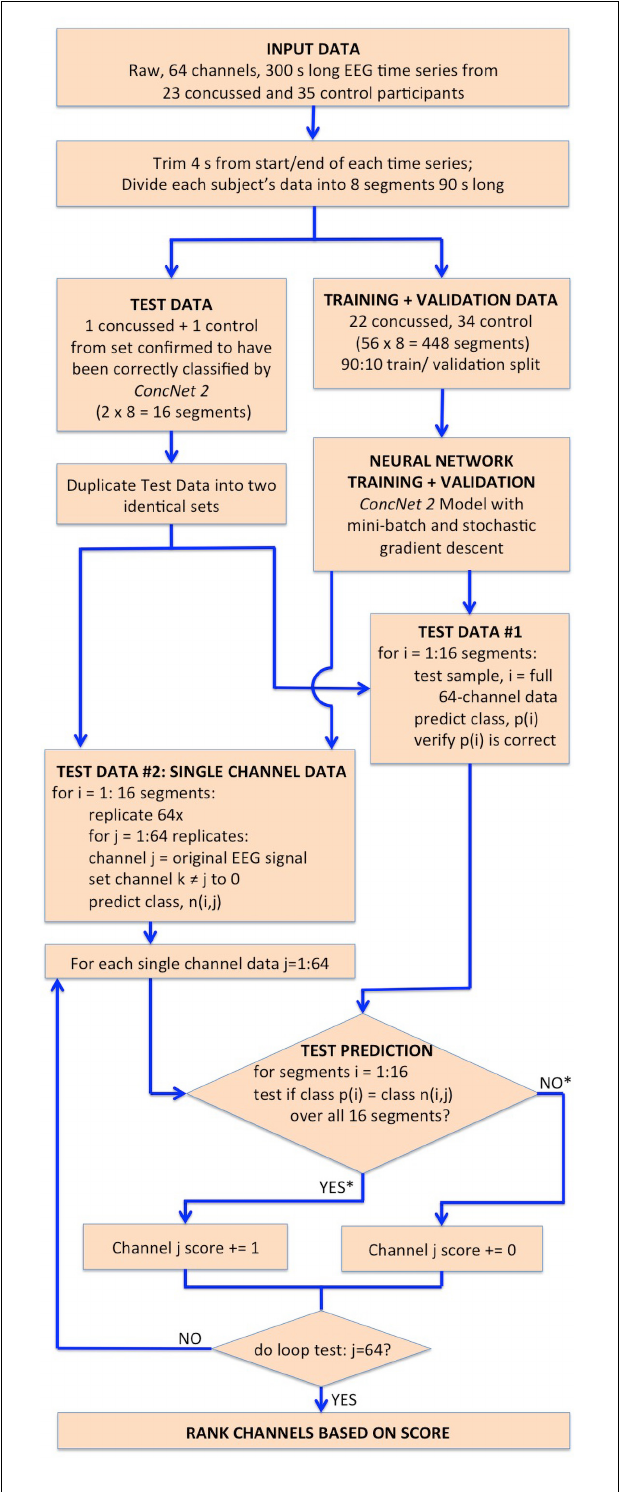
FIGURE 2 | Flowchart illustrating the steps followed in Stage I for the identification of the channels which have the highest impact on the classification performance of ConcNet 2 . The flowchart begins with the input dataset, followed by the trimming and segmentation of each participant’s